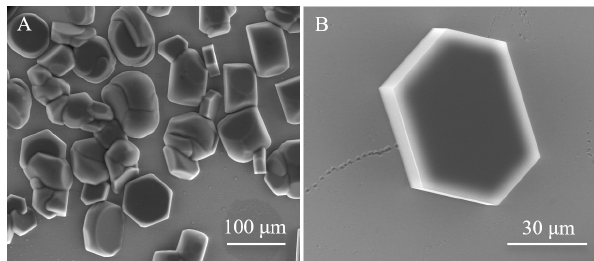
Figure 1. Ice growth examples recorded at 20kV. (a) Isolated crys- tals grown on an oxidized silicon wafer substrate. Note that some grains have started to touch, producing polycrystalline ice. ESEM imaging conditions: P = 135 . 1Pa, T = − 18 . 4 ◦ C, P sat = 120 . 4Pa, and h = 1 . 12. (b) An individual hexagonal crystal of ice on a clean silicon wafer. The basal plane is nearly parallel to the substrate. The outer rim is bright, an effect that might indicate charging. ESEM imaging conditions: P = 127 . 1Pa, T = − 18 . 7 ◦ C, P sat = 117 . 0Pa, and h = 1 .